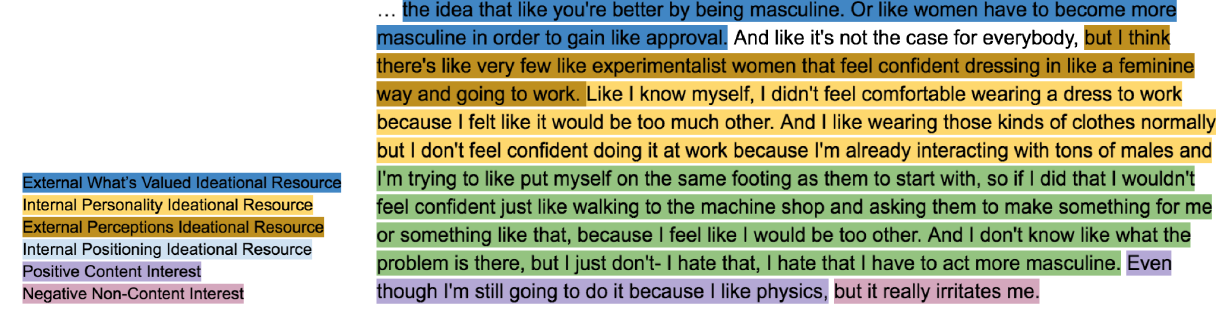
FIG. 5. An excerpt from Cindy ’ s coded interview using the Critical Physics Identity